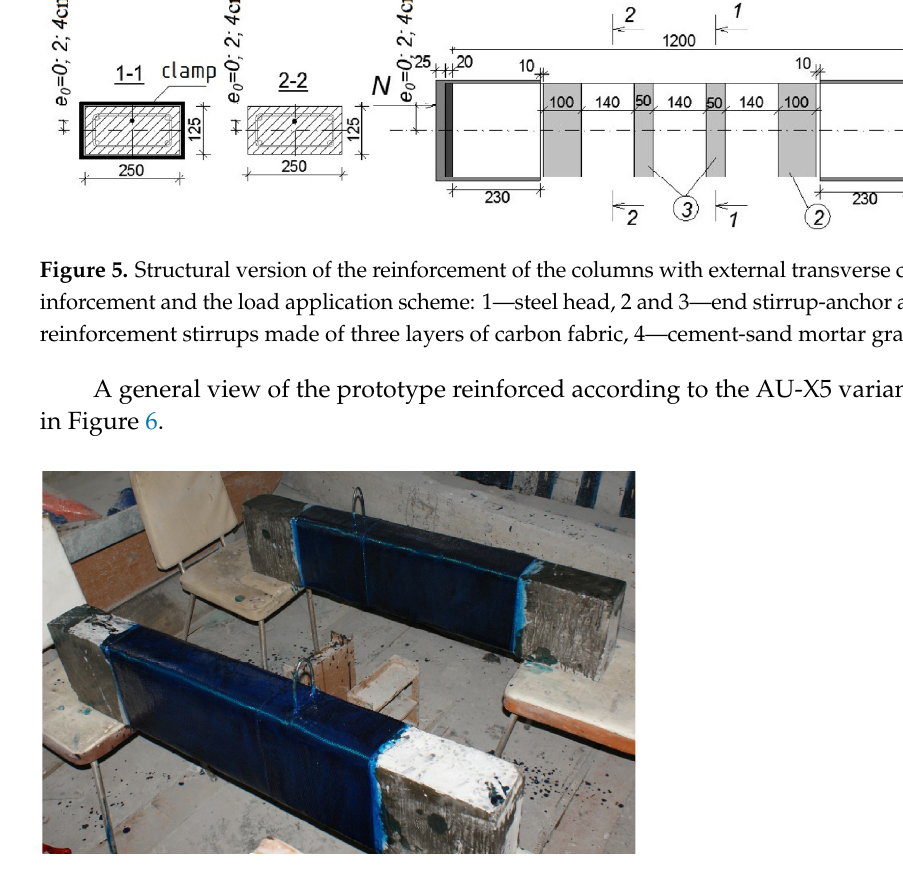
Table 3. Reinforcement variants and concrete strength characteristics of prototypes. Column Series